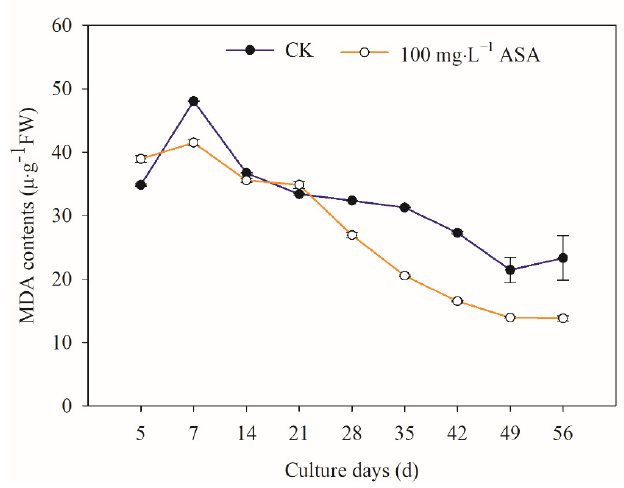
Figure 6. Effects of 0 and 100 mg · L − 1 ASA treatments on intracellular MDA content during somatic embryogenesis of Fraxinus mandshurica provenance 3. The x -axis represents the culturing days, and the y -axis represents the intracellular MDA content. Error bars show the standard error of the